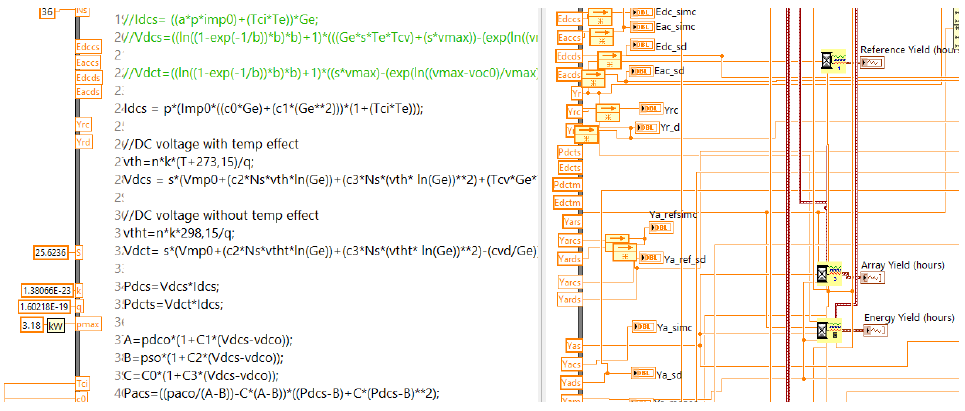
Figure 13. Sample of modeling code under LabVIEW block diagram.